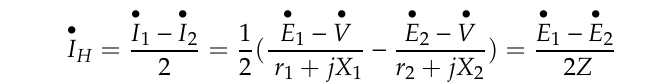
Figure 6 . Structure diagram of the droop control method introducing virtual impedance